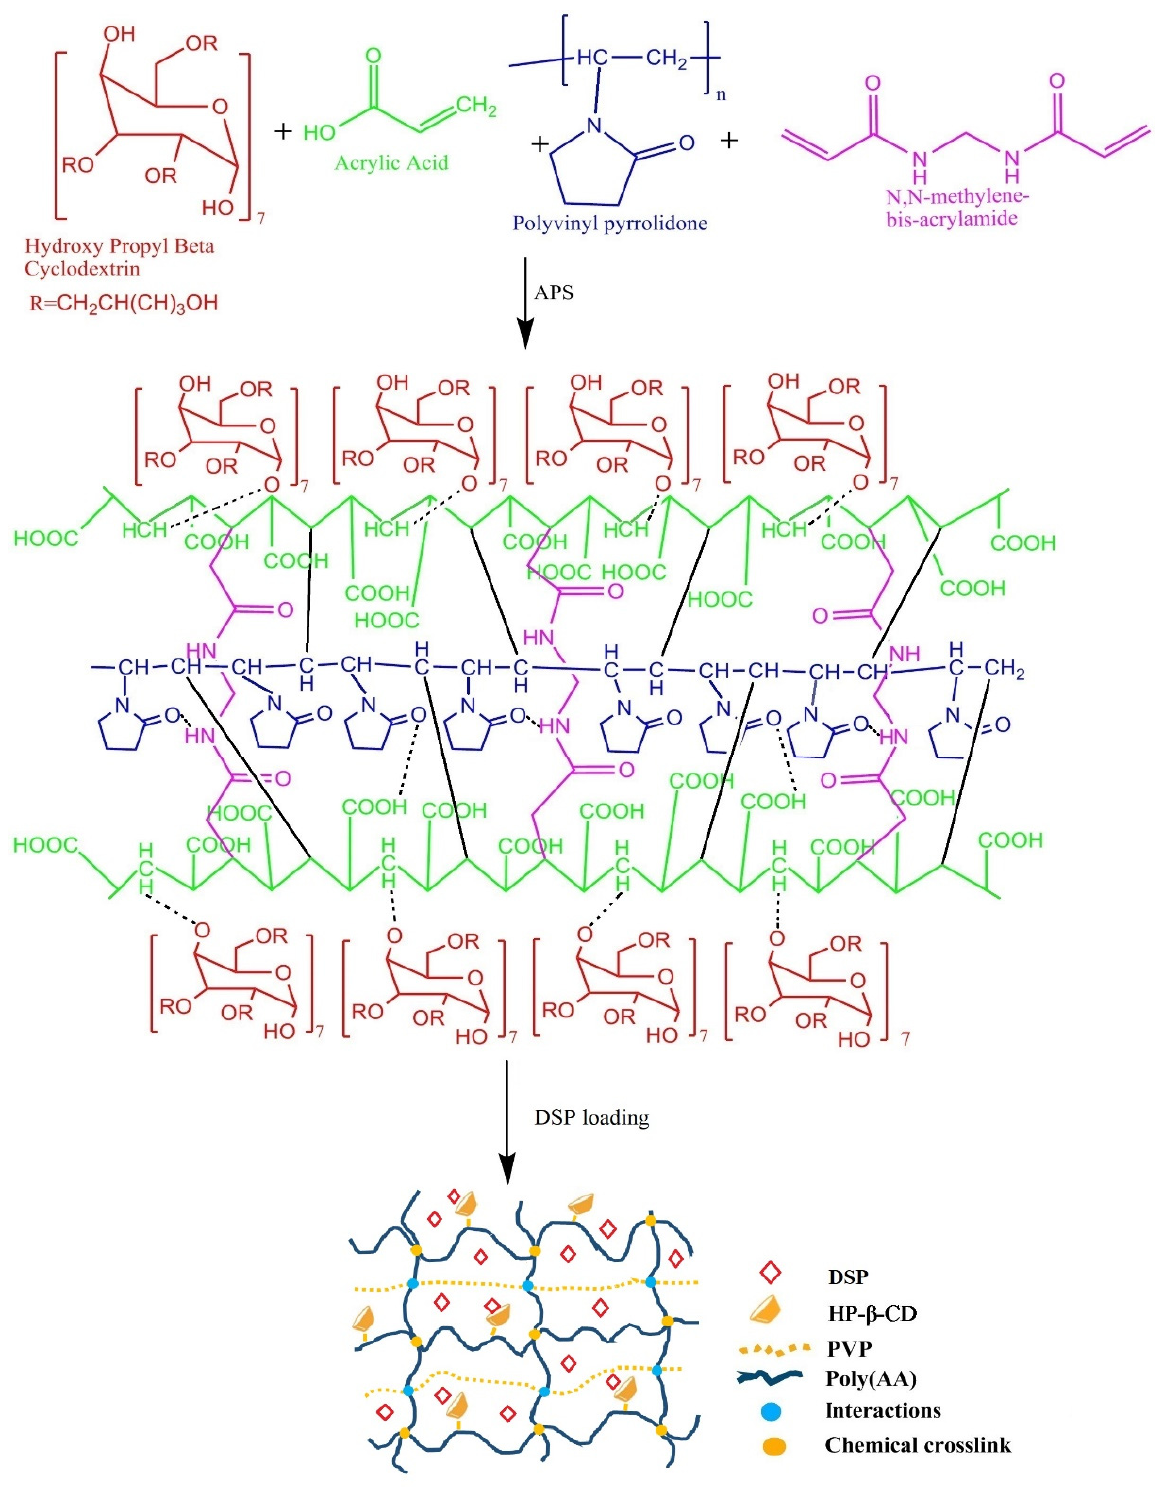
Figure 1. Initial ingredients, synthesis, possible structure, and DSP loading in pH-sensitive semi-IPN hydrogels.